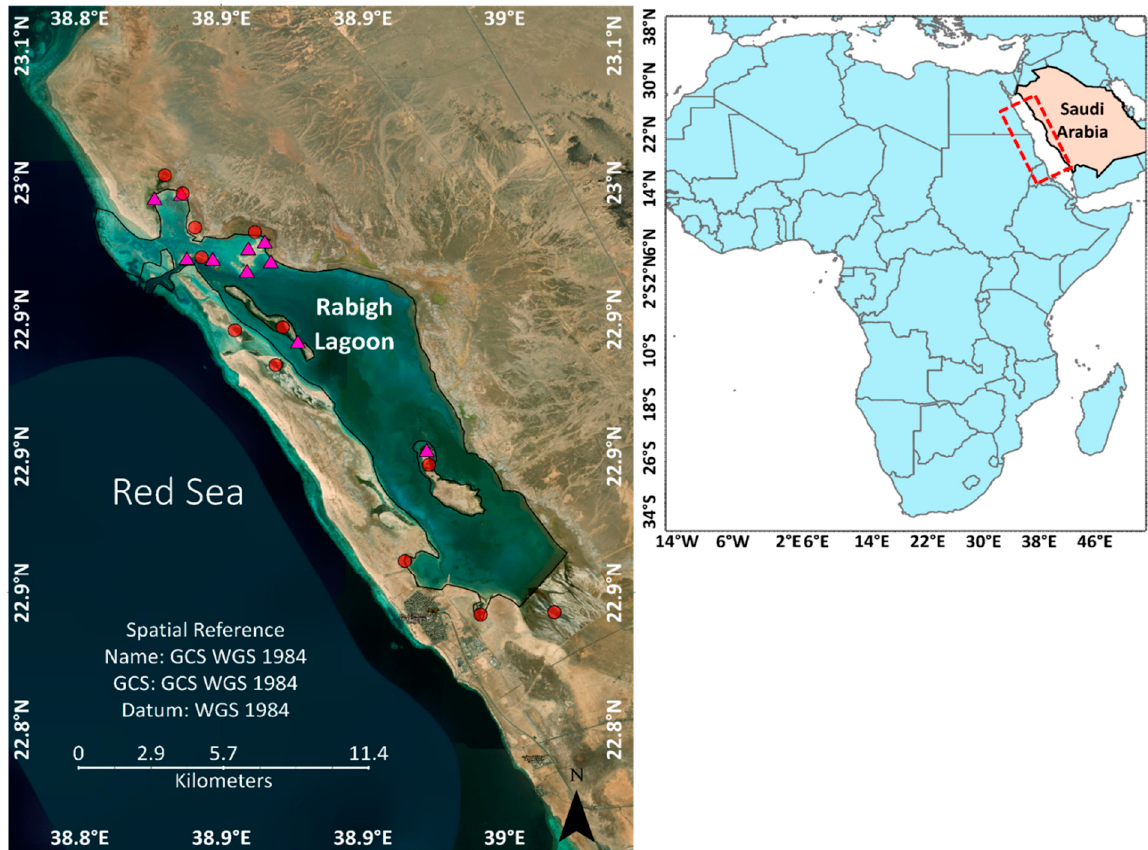
Figure 1. Map of study site, Rabigh Lagoon, located along the coast of Red Sea, Saudi Arabia. Pink triangles show locations for field visits. Red dots show locations from where pixel wise time series were extracted. GCS stands for Geographic Coordinate System. WGS stands for World Geodetic System.